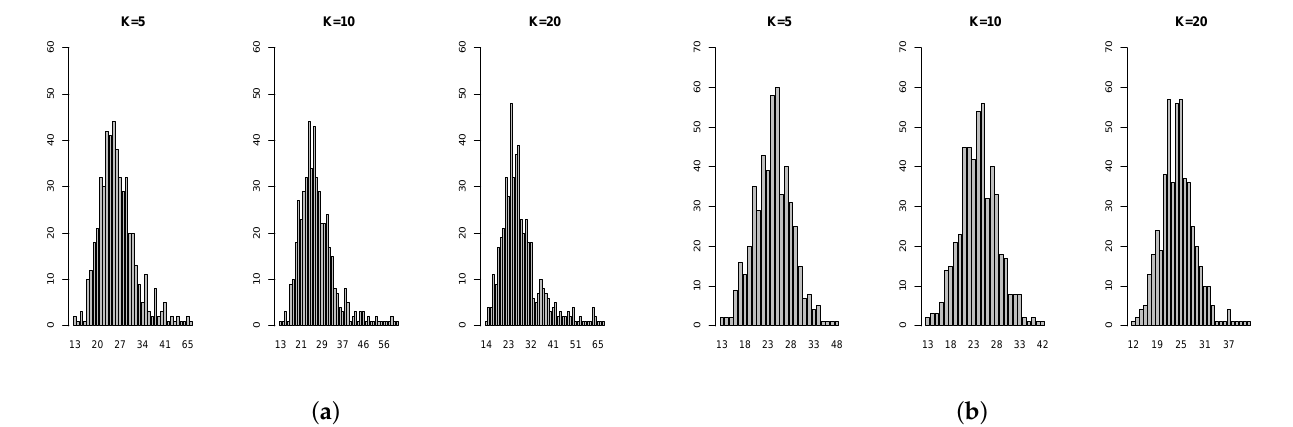
Figure A6. Bardet–Biedl data: | S (cid:53) ˆ S | ; S = var 1 se , ( a ) ˆ S = var min ; ( b ) ˆ S = var 1 se